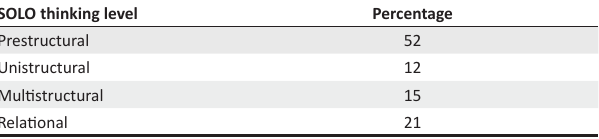
TABLE 1: Teachers’ statistical thinking levels for item number 3 (Handguns